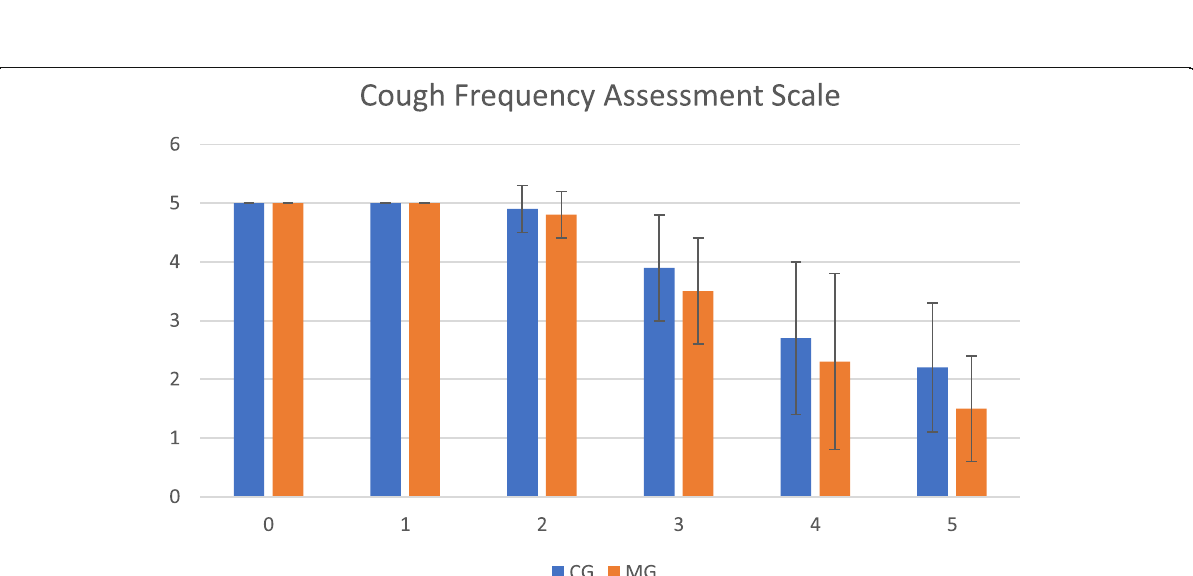
Fig. 2 Mean of the scores in CG (control group = standard antiviral): visit 0 = 5.0 SD(0.0), visit 1 = 5.0 SD(0.0), visit 2 = 4.9 SD(0.4), visit 3 = 3.9 SD(0.9), visit 4 = 2.7 SD(1.3), visit 5 = 2.2 SD(1.1). Mean of the scores in MG (main group = standard antiviral + cineole): visit 0 = 5.0 SD(0.0), visit 1 = 5.0 SD(0.0), visit 2 = 4.8 SD(0.4), visit 3 = 3.5 SD(0.9), visit 4 = 2.3 SD(1.5), visit 5 = 1.5